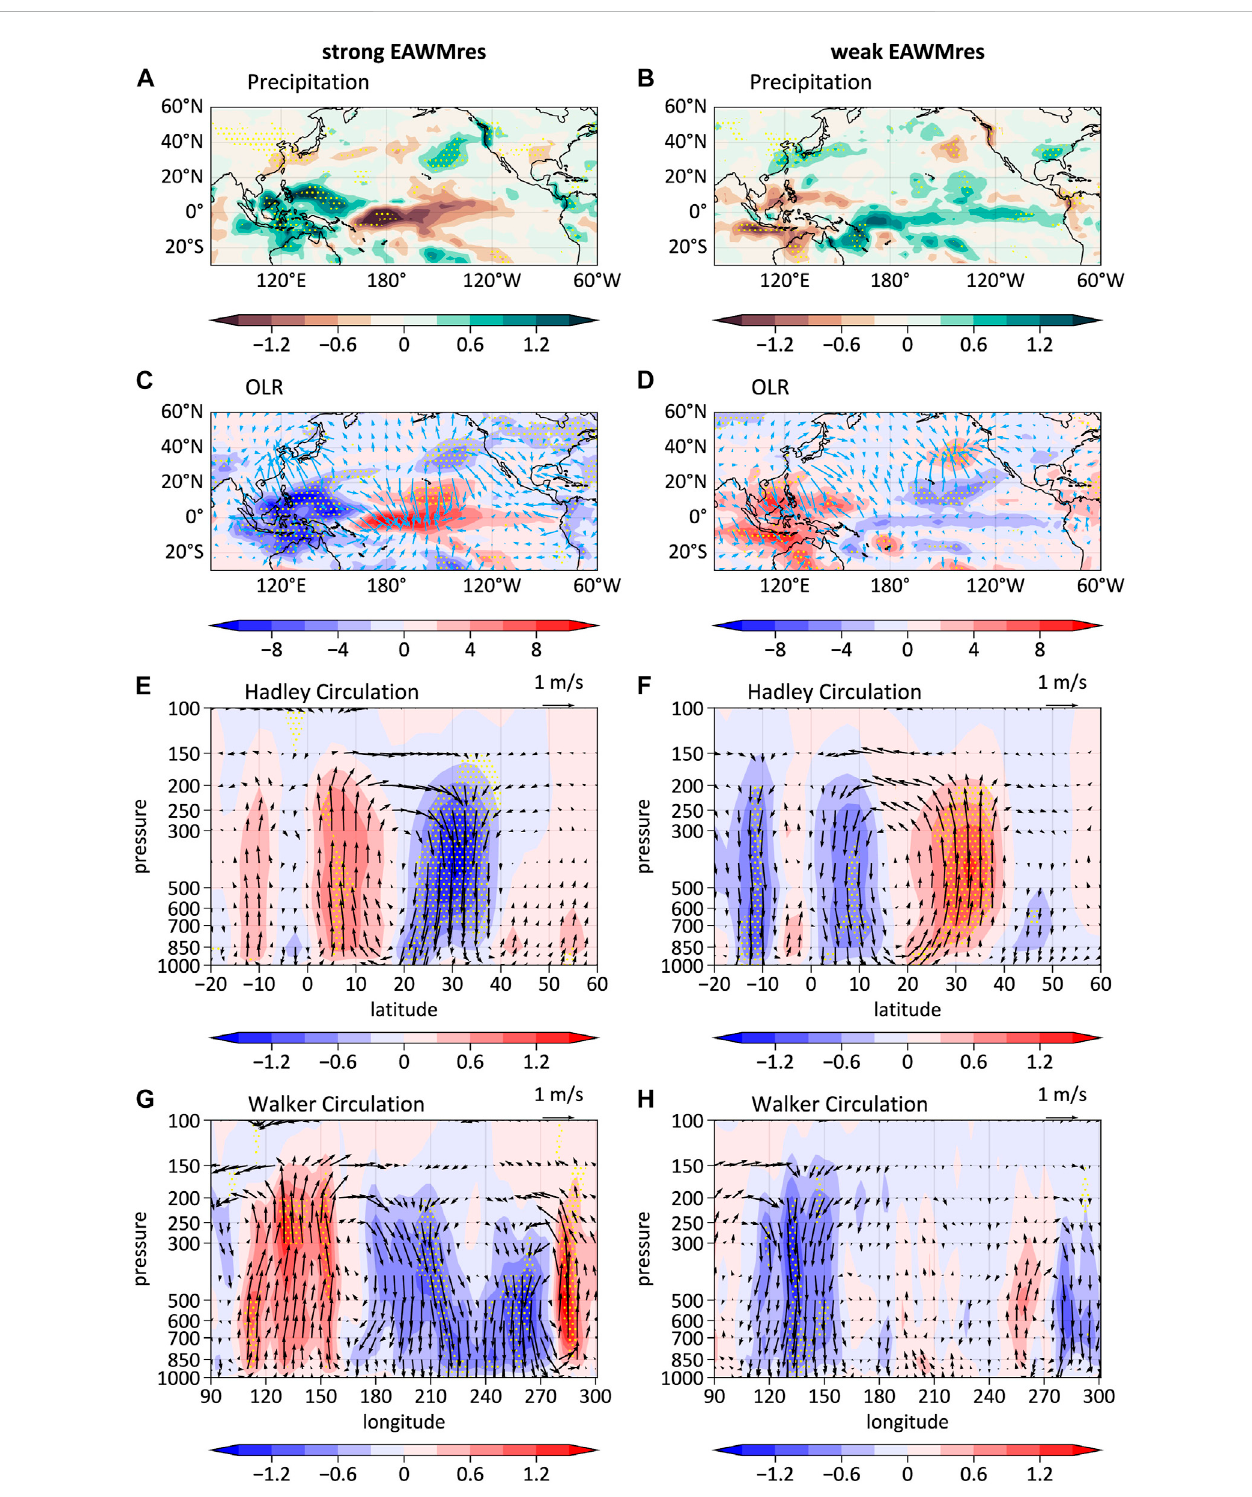
Composite anomalous patterns for the strong (left column) and weak (right column) EAWM res winters: (A, B) precipitation (mm day − 1 ), (C, D) outgoing longwave radiation (OLR, color, W m − 2 ) and divergent winds at 200-hPa (vector, m s − 1 ), (E, F) zonal-averaged vertical velocity (shading, − 10 − 2 Pa s − 1 ) and meridional divergent wind (vector, m s − 1 ) along East Asia (100 ° – 140 ° E), and (G, H) meridional-averaged vertical velocity and zonal divergent wind (vector, m s − 1 ) over (0 ° – 10 ° N). Dotting indicates the anomalies that exceed the 95% con fi dence